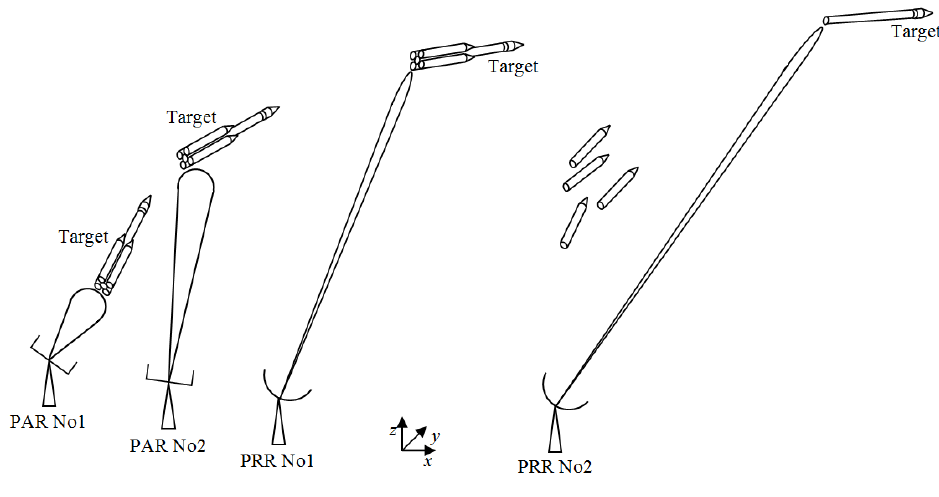
Figure 6. Tracking network with phased array radars (PARs) and parabolic reflector radars